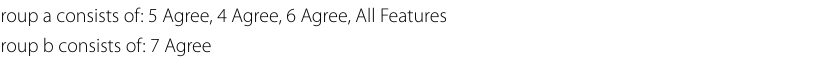
Table 45 HSD test groupings after ANOVA of AUPRC for the FST